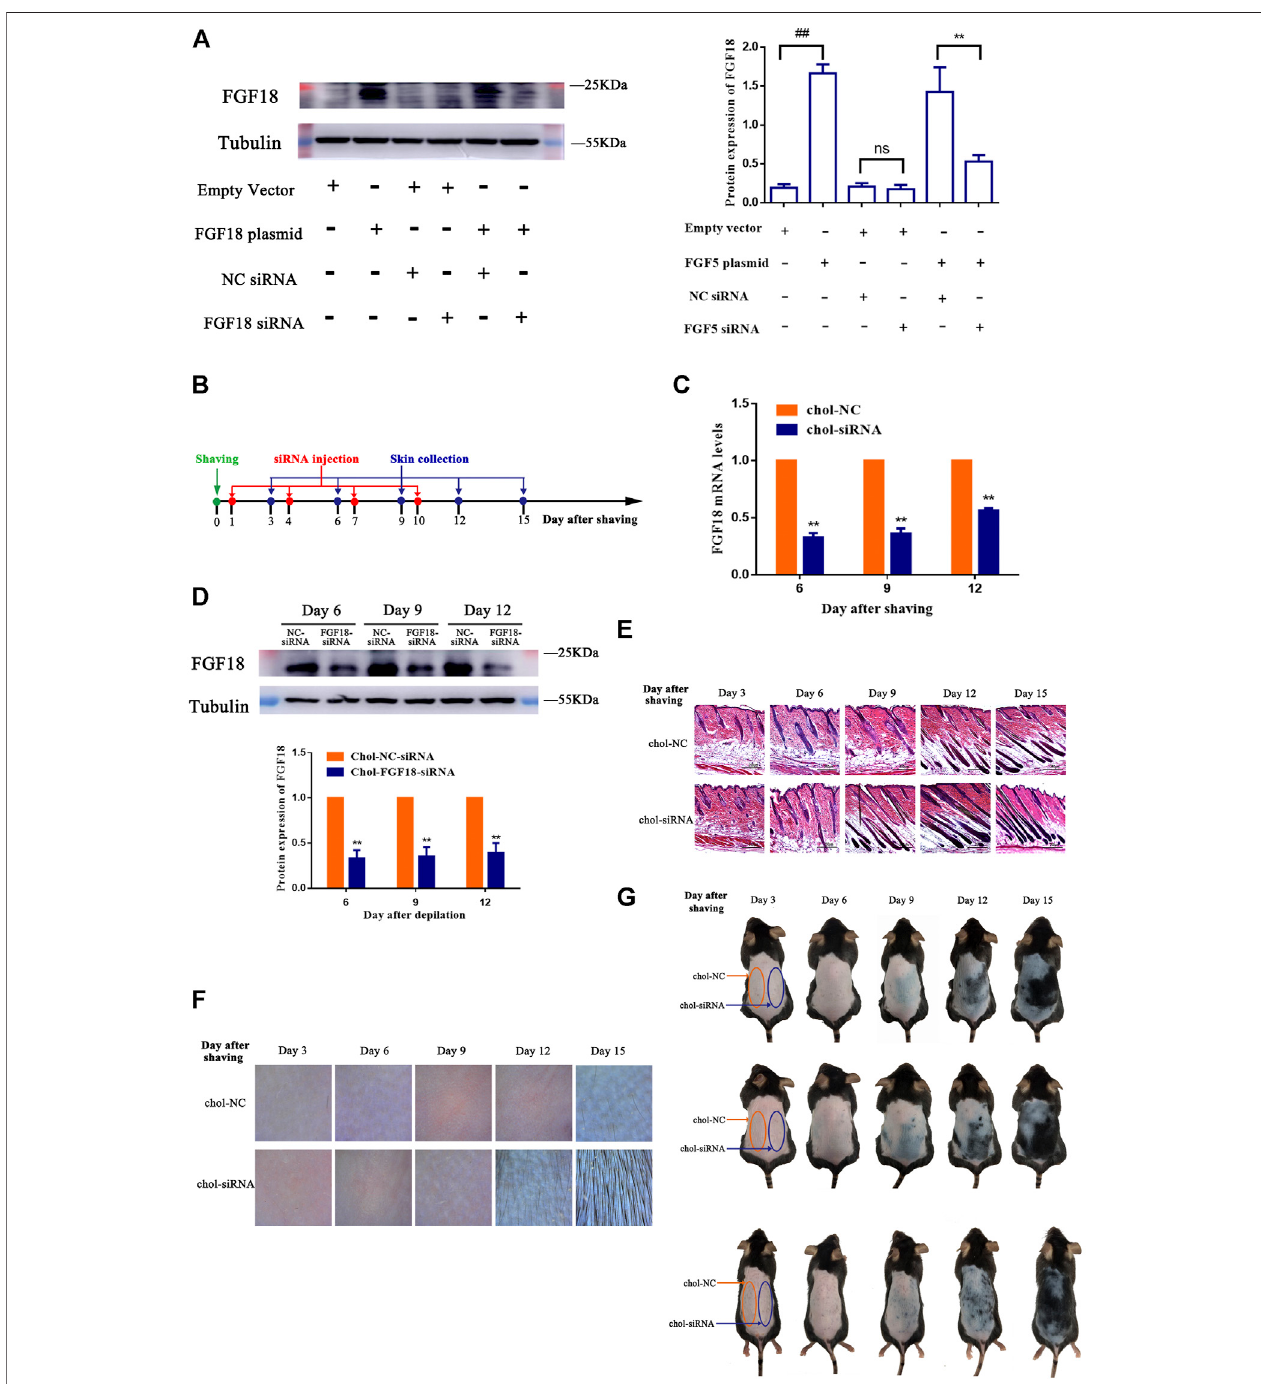
FIGURE 3 | Effect of FGF8 siRNA on the expression of FGF8 in mouse skin (A) Effect of FGF18 siRNA on the expression of FGF18 in NIH-3T3 cells. NIH-3T3 cells were transfected with an empty vector or vector containing the FGF18 gene and the level of FGF18 secreted by the cells was then measured by western blot following transfection with the cholesterol-modi fi ed negative control siRNA (NC siRNA) or cholesterol-modi fi ed FGF18 siRNA. The plot shows the corresponding western blot result. Data are mean ± SD ( n (cid:2) 3). ** p < 0.01, ## p < 0.01 (B) Diagram depicting the timeline in the establishment of the model used for the administration of Chol- FGF18-siRNA and collection of skin samples. Chol-FGF18-siRNA or Chol-NC-siRNA was delivered to the mouse skin by intradermal injection one day after depilation, and the mRNA level of FGF18 in the skin tissue was measured by PCR (C) whereas the protein level of FGF18 was measured by western blot (D) at the indicated times. The plot below the blot in (D) shows the quantitation of the protein bands in the blot as determined by grayscale. Data are mean ± SD ( n (cid:2) 3). ** p < 0.01 vs. Chol-NC siRNA (E) HEstainingofskintissueshowingthedifferentphasesofthehairfolliclecycle. (F) Digitalimagesshowingtheextentofhairgrowthontheskinasdetectedbya hair follicle detector at 200 × magni fi cation following injection of siRNA. (G) Digital images showing the back of the mice after injection with FGF18-targeted siRNA and NC-siRNA following depilation.